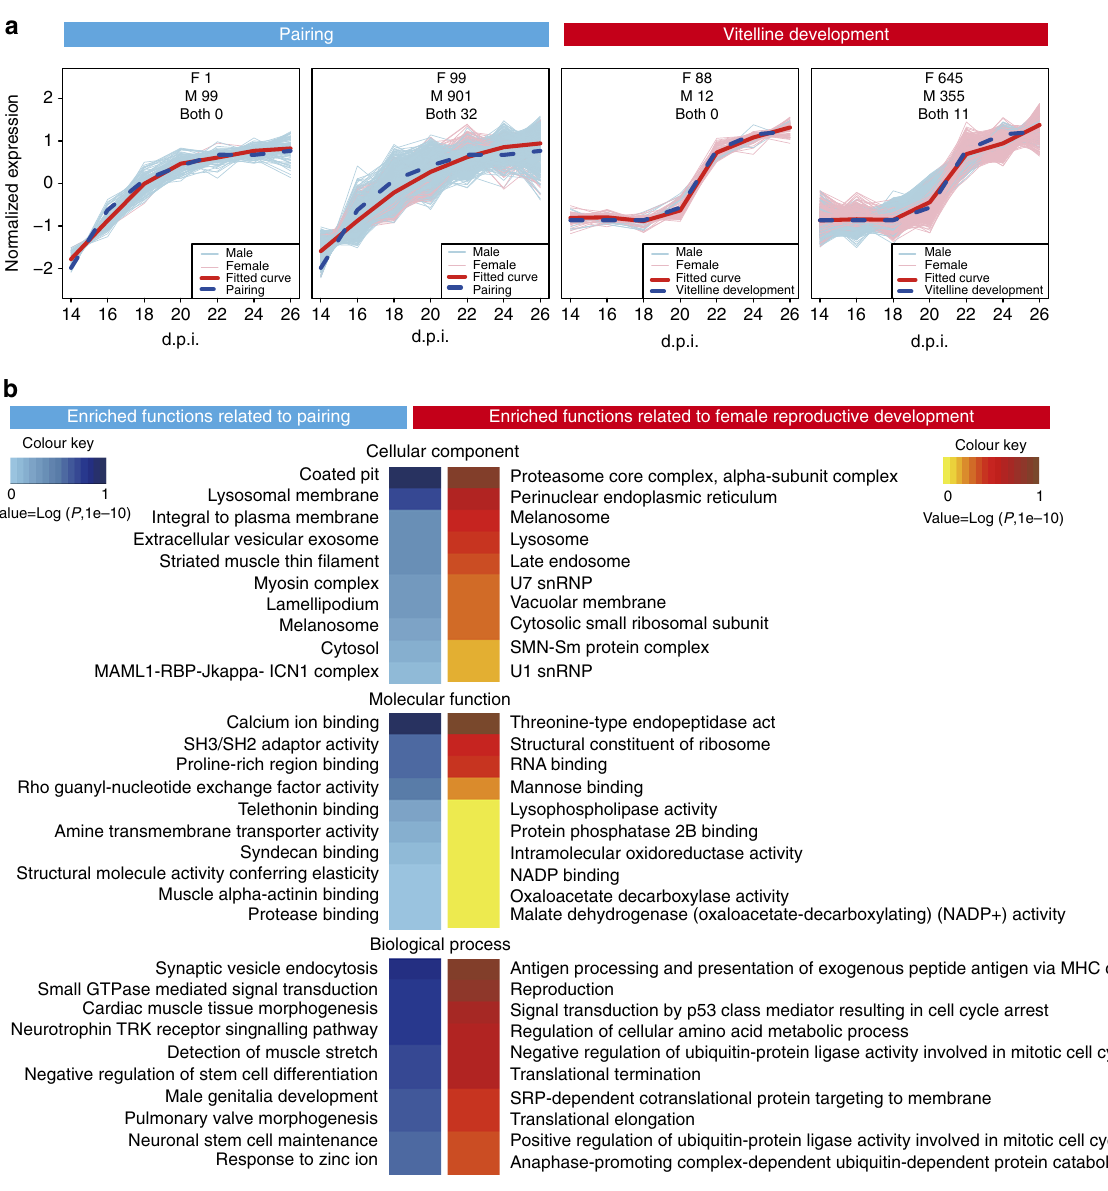
Figure 3 | Functional genes associated with pairing and reproductive development in schistosomes. ( a ) Top 100 and 1,000 transcripts in which expression patterns exhibited positive correlations with the rate of in vivo male–female pairing and female vitelline development. ( b ) GO enrichment of the genes expressed that were associated with pairing and development of the